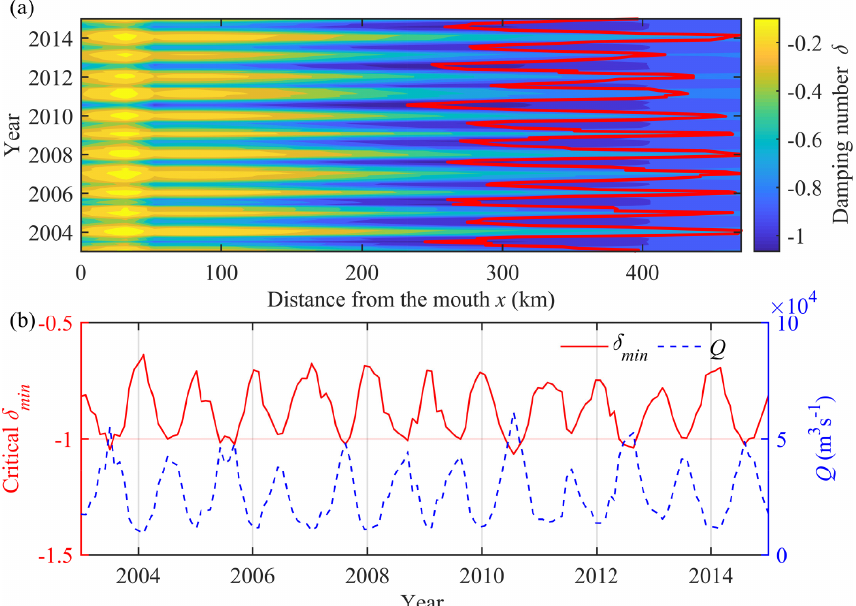
Figure 6. Contour plot of the damping number δ and its minimum value δ min (indicated by the red line) for each month (a) , and the relation between the critical value and river discharge Q (b)